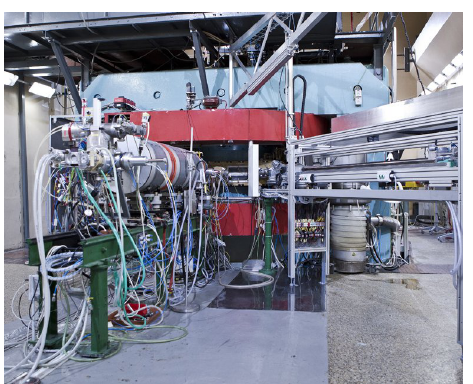
Figure 1. The cyclotron